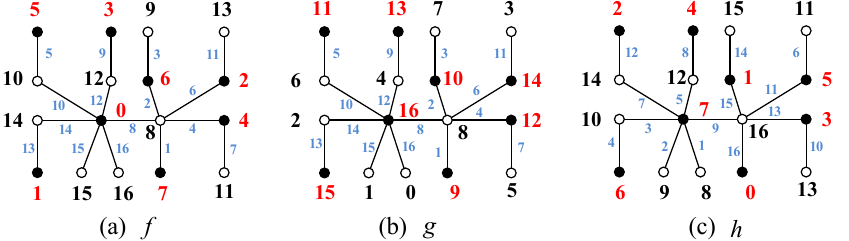
Figure 2. ( a ) A set-ordered graceful labeling f of a tree T ; ( b ) A set-ordered graceful labeling g of T holding f ( v ) + g ( v ) = p − 1 = 16; ( c ) A set-ordered graceful labeling h of T holding f ( uv ) + h ( uv ) = q + 1 =